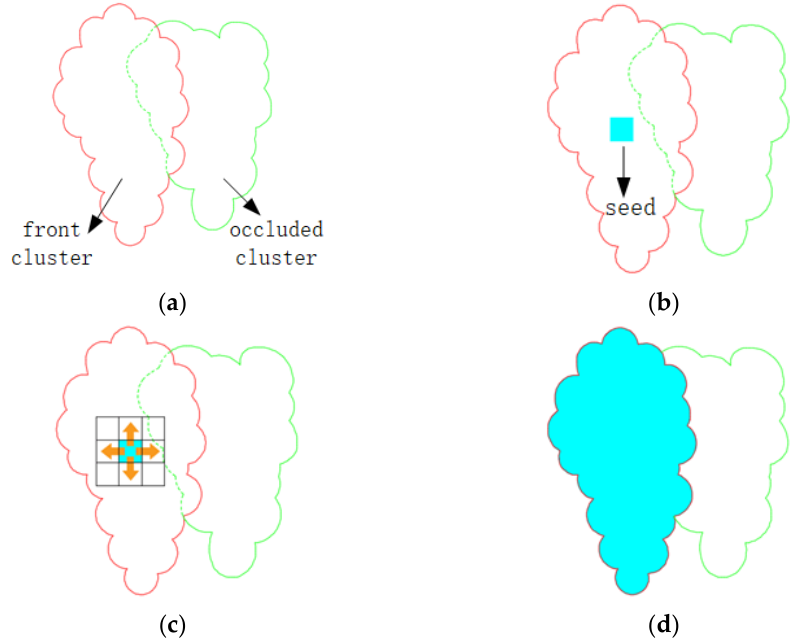
Figure 3. The steps of the proposed depth region method. ( a ) The overlapping grape clusters, ( b ) the seed point, ( c ) region growing, and ( d ) the extracted front cluster.